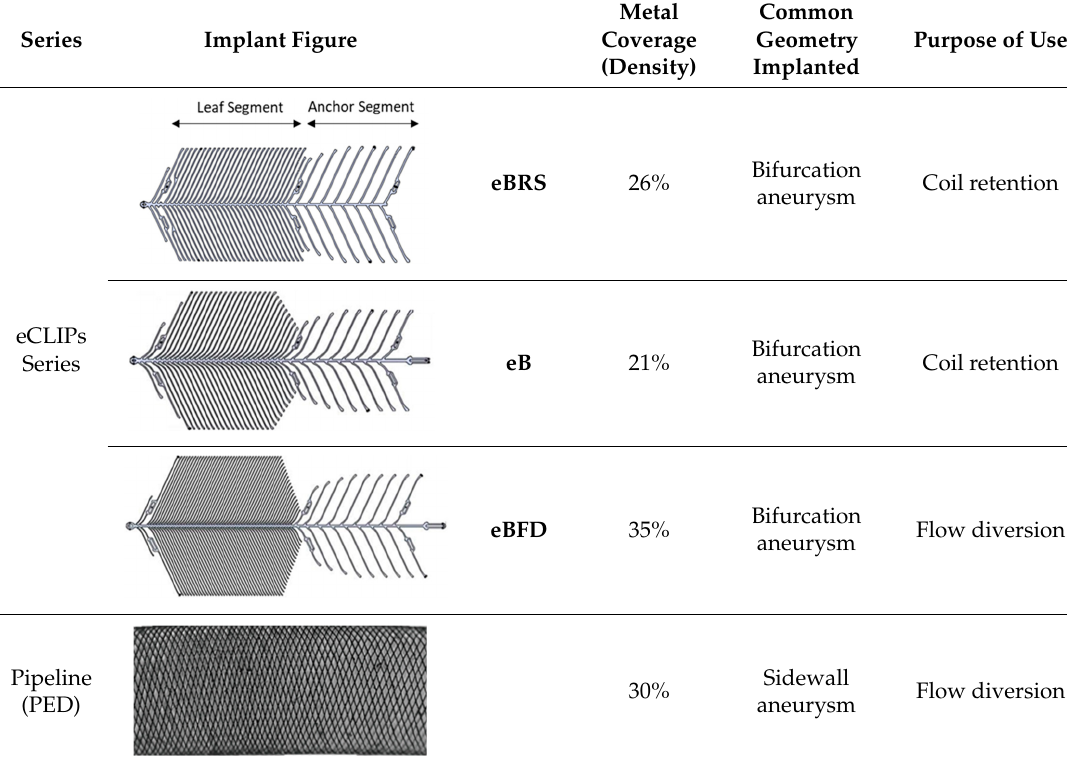
Table 1. Illustration and general characteristics of the three versions of eCLIPs and Pipeline studied using particle image velocimetry (PIV) analysis; the Pipeline device image was adapted from Dholakia et al. [21].